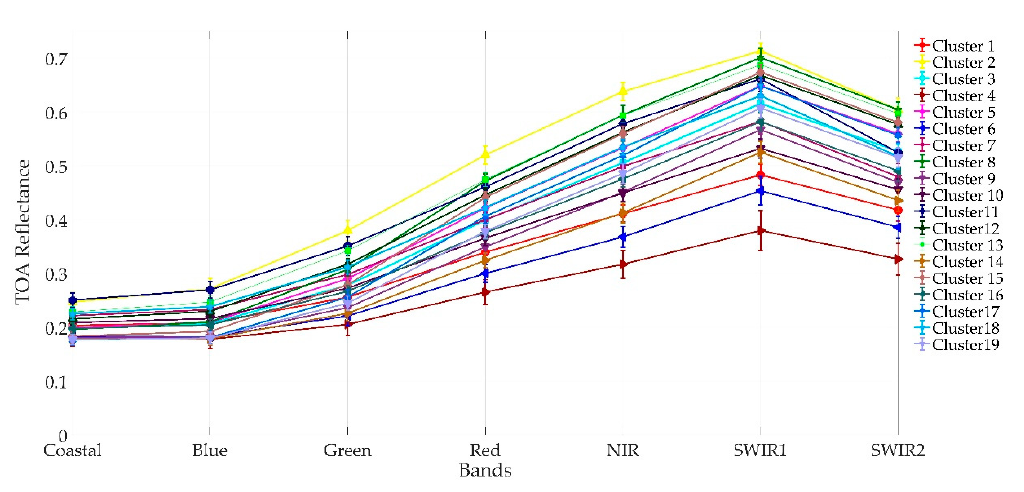
Figure 5. Spectral Signature of Clusters, by Band.